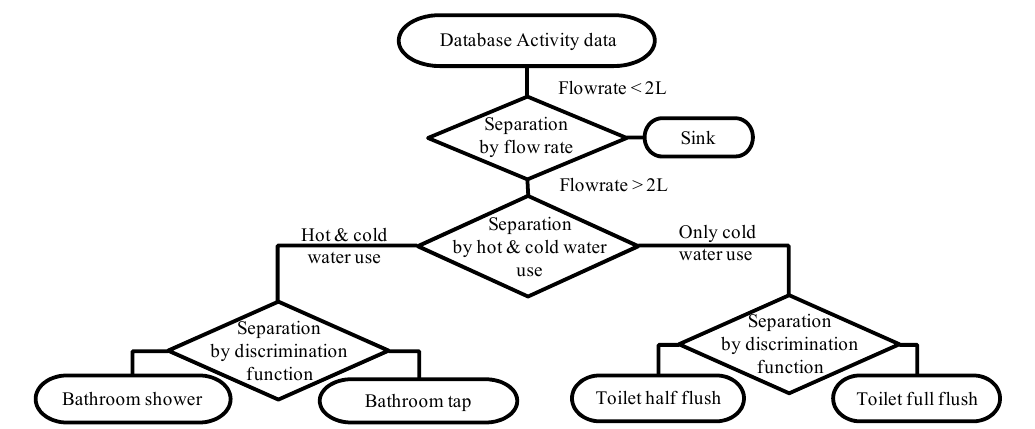
Figure 3. The flowchart used to separate activities.